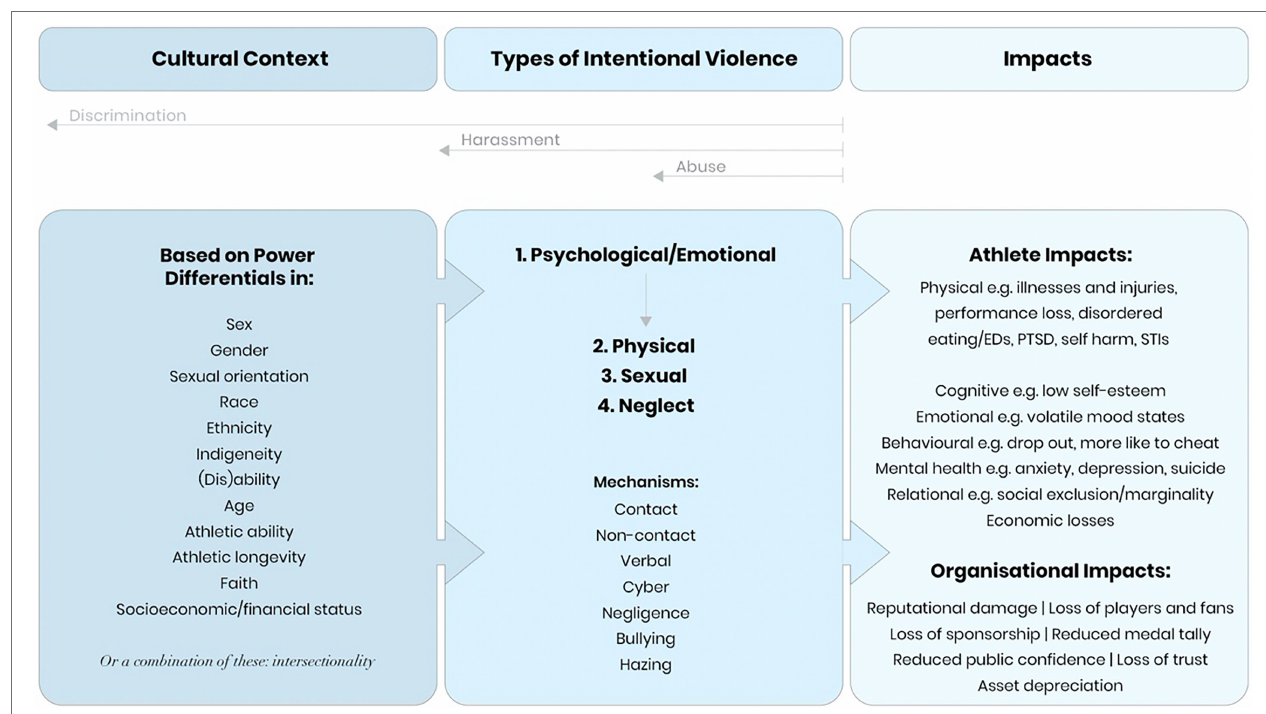
FIGURE 1 | Conceptual model of intentional violence in sport, highlighting the central role a psychological power imbalance plays for all forms of harassment and abuse. Eds, Eating disorders; PTSD, post-traumatic stress disorder; STIs, Sexually transmitted illnesses. Figure adapted from Mountjoy et al. (2016).